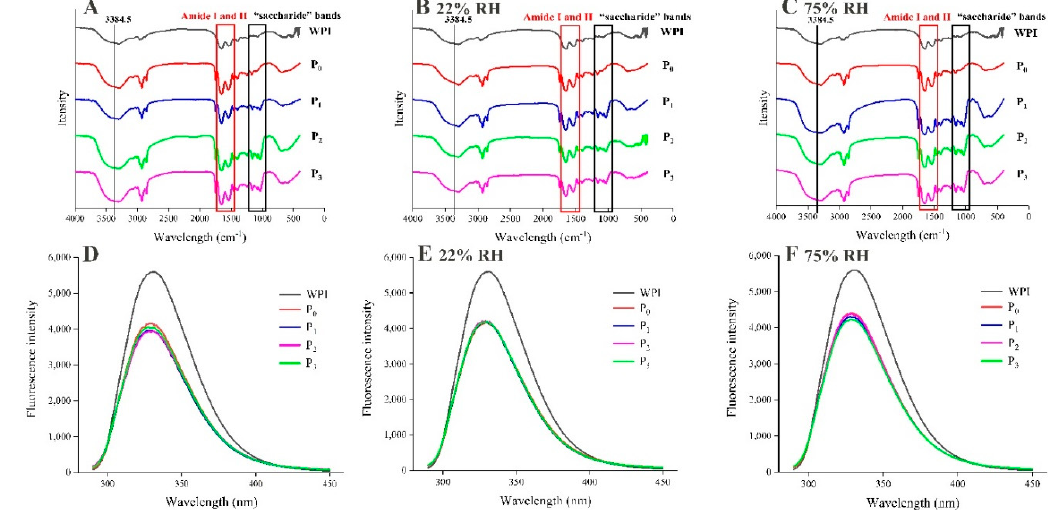
Figure 5. FTIR and fluorescence spectrum for WPI and powdered microcapsules of storage for 12 h. (( A ) FTIR before storage, ( B ) FTIR at 22% RH, ( C ) FTIR at 75% RH, ( D ) Fluorescence spectrum before storage, ( E ) Fluorescence spectrum at 22% RH, ( F ) Fluorescence spectrum at 75% RH).